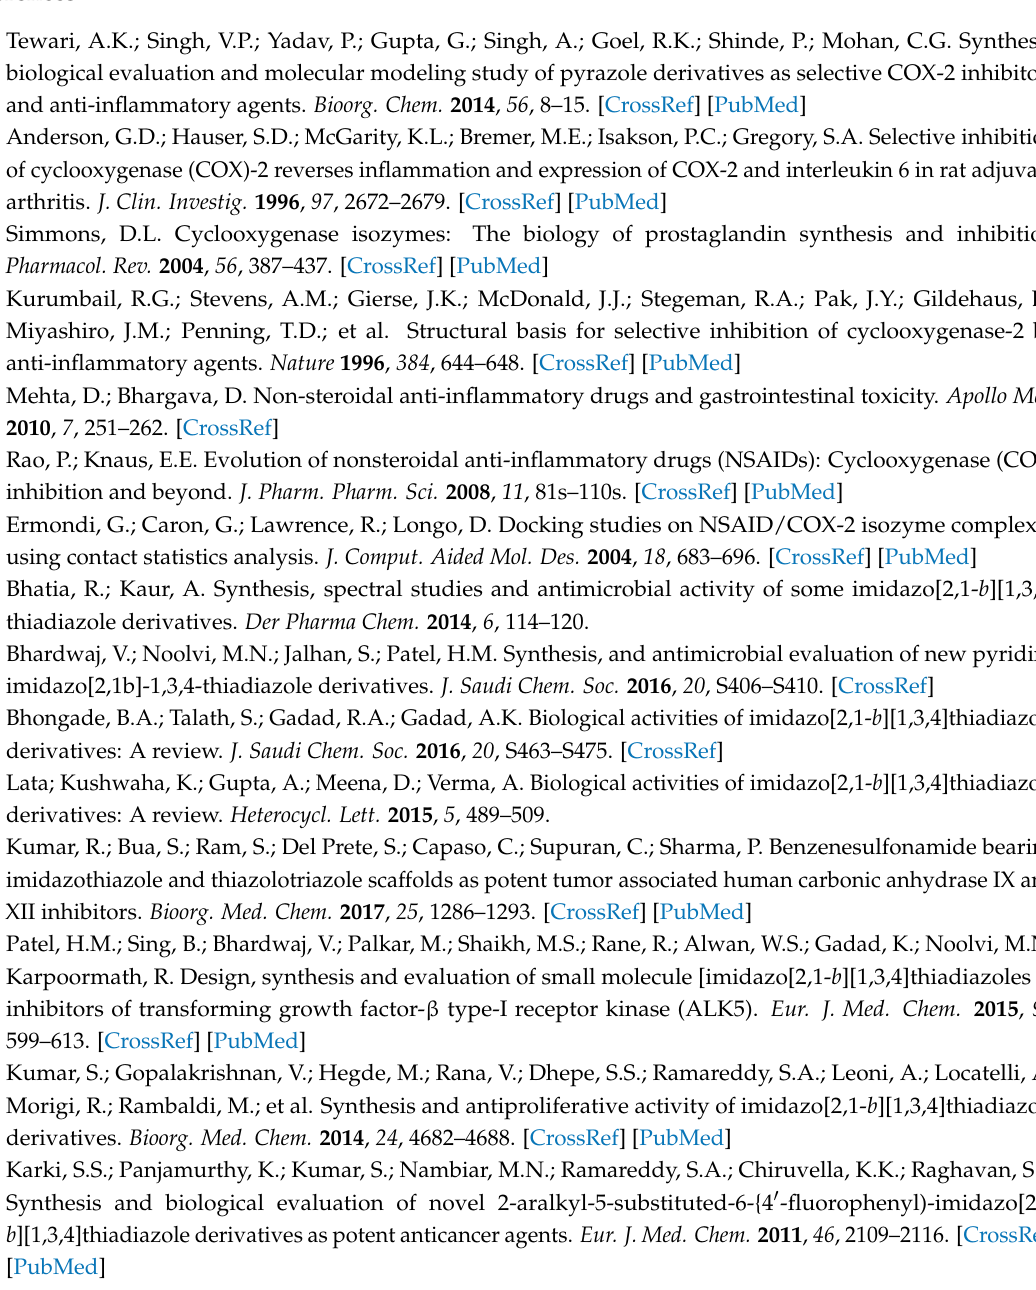
Supplementary Materials: The following are available online, Figure S1: Alignment of amino acids in COX-1, Figure S2: Alignment of amino acids in